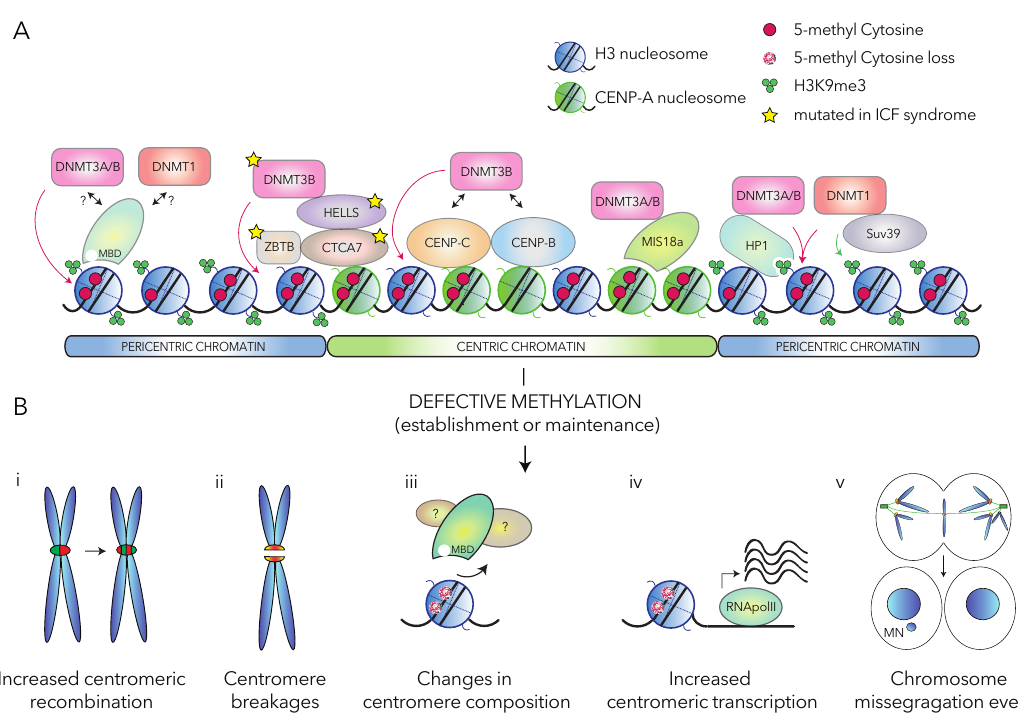
Figure 1. ( A ) Schematic representation of some proposed mechanisms of DNA methylation establishment and maintenance at (peri)centromeric regions. Centromeric proteins CENP-A, -B, -C recruit, by direct or indirect interactions, the indicated DNA methyltransferase enzymes to centromeric